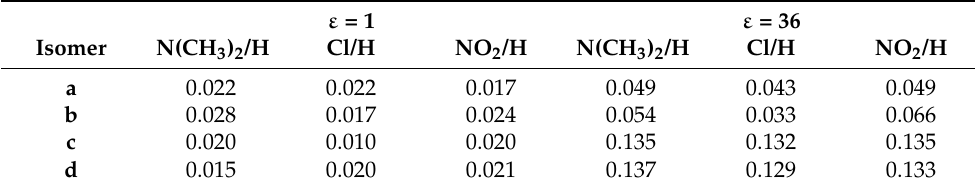
Table 6. RMS deviation of the partial charges between structures with different substituents for DFT calculation in gas phase ( ε = 1) in acetonitrile ( ε = 36) for isomers a – d . ε = 1 ε = 36 Isomer N(CH 3 ) 2 /H Cl/H NO 2 /H N(CH 3 ) 2